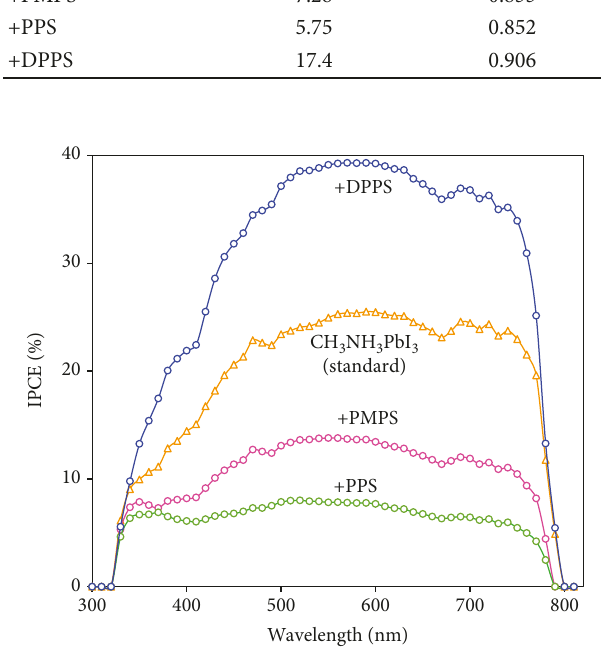
Figure 3: IPCE spectra of CH